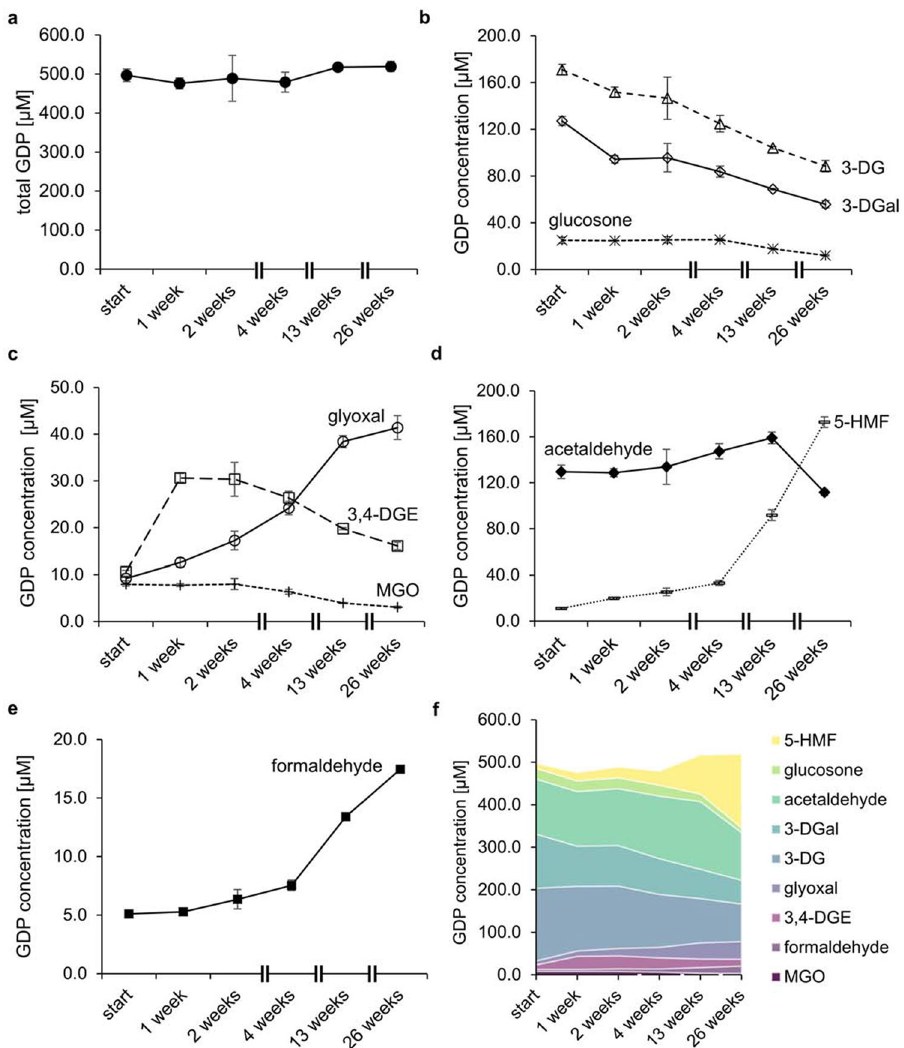
Figure 3. GDP concentration in single-chamber PDFs over storage time. ( a ) Total GDP content (filled circle); ( b ) 3-DG (open triangle), 3-DGal (open diamond), and glucosone (asterisk); ( c ) 3,4-DGE (open square), glyoxal (open circle), and MGO (plus symbol); ( d ) acetaldehyde (filled diamond) and 5-HMF (dashed line); ( e ) formaldehyde (filled square); ( f ) stacked area graph showing all quantified GDPs. Mean values ± standard deviation of three different PDF bags are displayed (except for week 13, for which the mean values ± range of two bags are